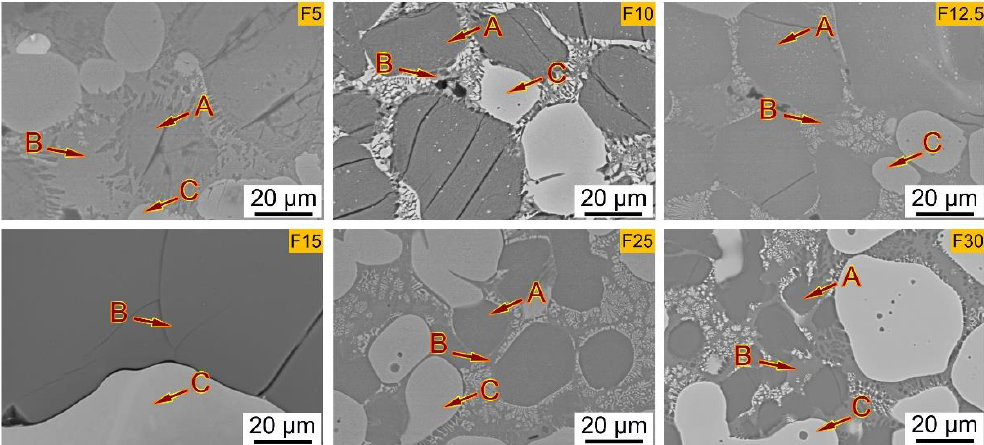
Figure 7. SEM images with the magnification of 200 times for the Fe 2 O 3 addition amount of 5, 10, 12.5, 15, 25 and 30 g.